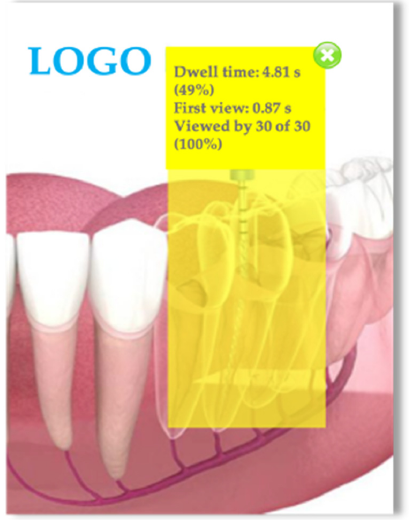
Figure 8. Images ( A ) and ( B ) with the designation of areas of interest 1 and 2.